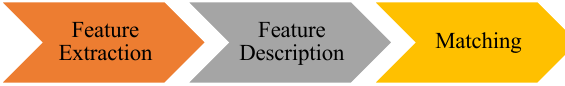
Figure 7 . Image Matching Process.